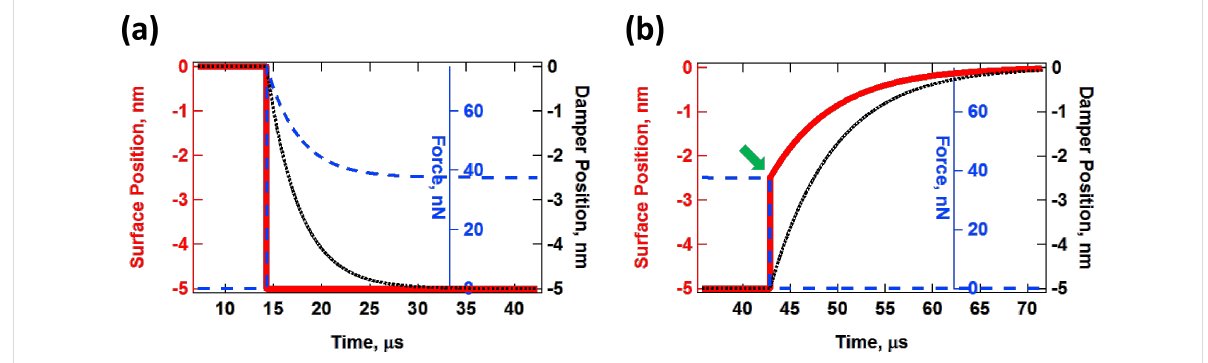
Figure 2: (a) Illustration of stress relaxation and (b) creep (the various traces are color coded with their respective axes). In (a) the surface is depressed and held fixed at a position of 5 nm below its relaxed state, starting at t = 15 μ s. Following the simulation described in (a) the surface is released at t = 43 μ s and its response is plotted in (b). The magnitude of the immediate elastic relaxation of the surface upon release, indicated by the green arrow in (b), depends on the ratio and magnitudes of the two spring constants, K inf and K 0 (see Figure 1). The simulation parameters were K inf = K 0 = 7.5 N/m and C diss = 2.5 × 10 − 5 N·s/m.